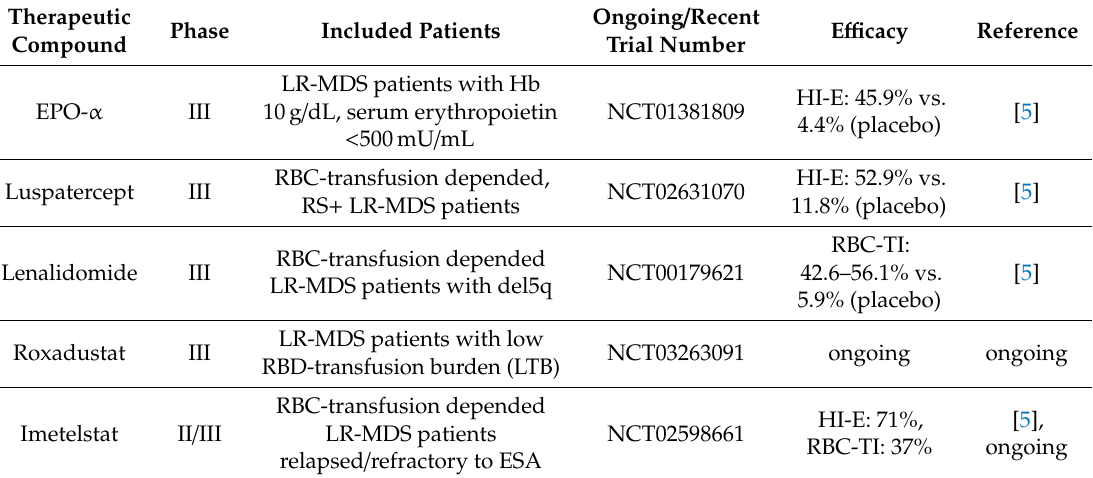
Table 1. Targeted treatment options for anemic lower-risk MDS